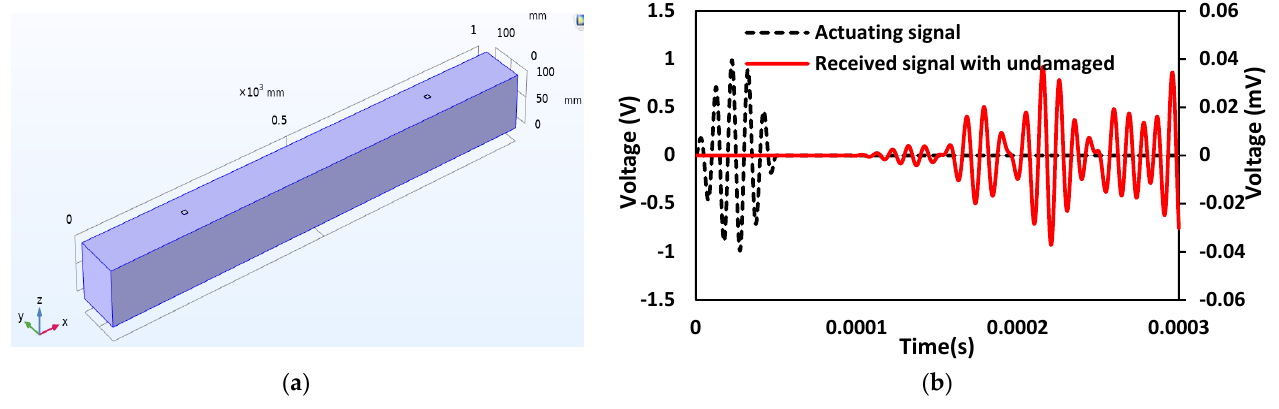
Figure 13. Concrete beam with two PZT sensors attached to the surface of the beam: ( a ) Schematic 3D model; ( b ) Response spectrum obtained from wave propagation measurements in the actuator– receiver mode.